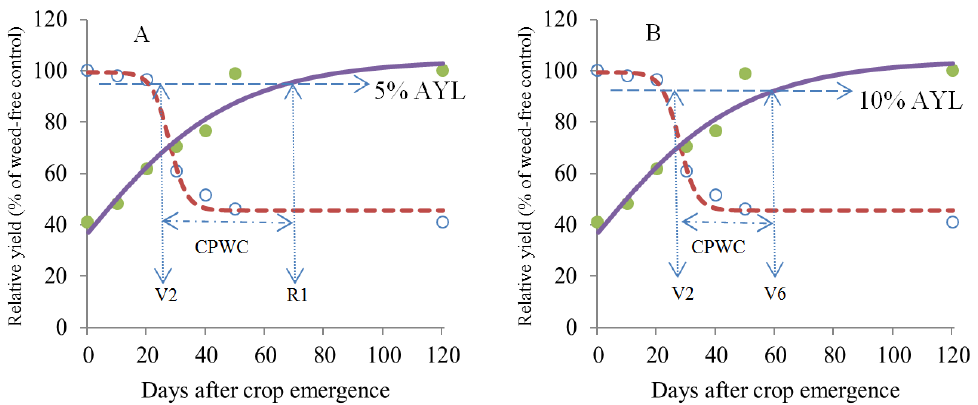
Fig. 4. Effect of increase in duration of weed interference (empty circles) and weed free periods (dots) on relative yield of dry bean. Horizontal dashed arrow indicates acceptable yield lost at 5% (A) and 10% (B). Parameter values for fitted curves are given in Tab. 3 and